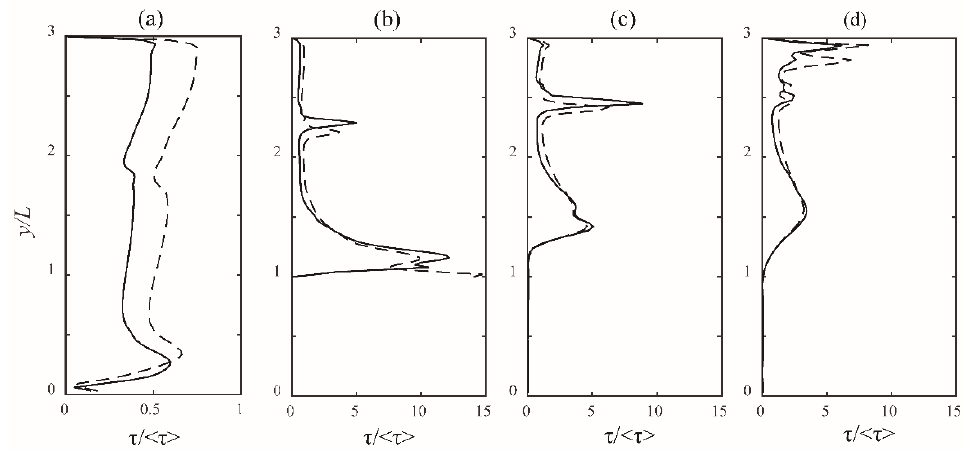
Figure 6. Bed shear stress profiles normalized by the uniform flow bed shear stress at selected longitudinal stations at ( a ) x = − 1, ( b ) x = 0, ( c ) x = 1 and ( d ) x = 2. Dashed lines represent Case 1 and solid lines represent Case 2.